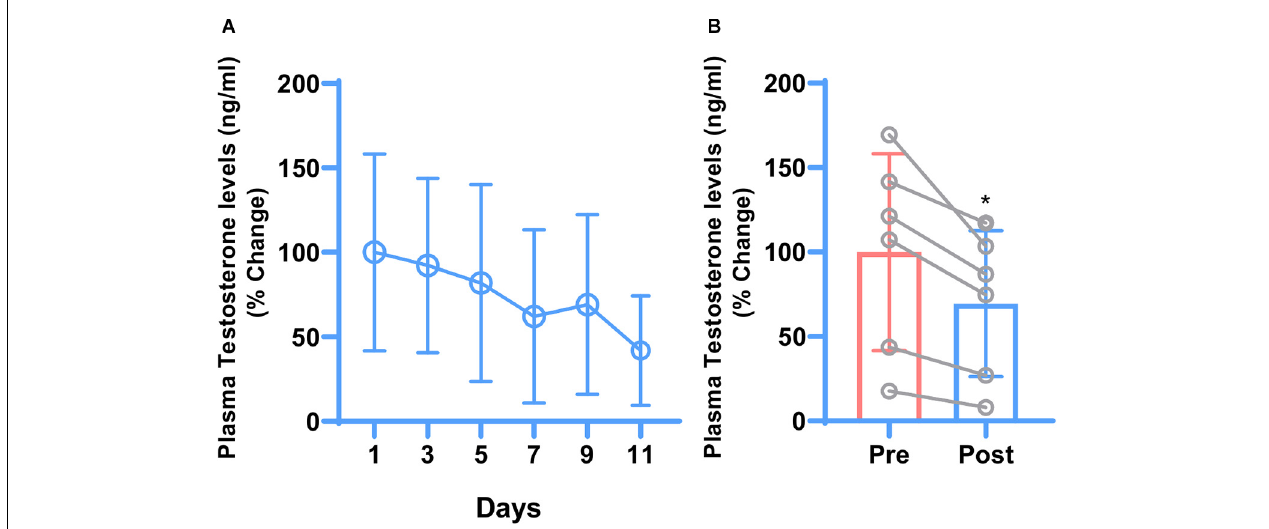
FIGURE 1 | Daily changes in mean plasma testosterone concentrations during 11 days of hydrocortisone treatment in adult male rhesus macaque ( n = 6). One-way ANOVA showed decreasing trend of testosterone levels but because of the big variations, the difference was not significant (A) . Similarly, paired t -test showed that hydrocortisone significantly (* P ≤ 0.0127) decreased the overall mean plasma testosterone (B) .